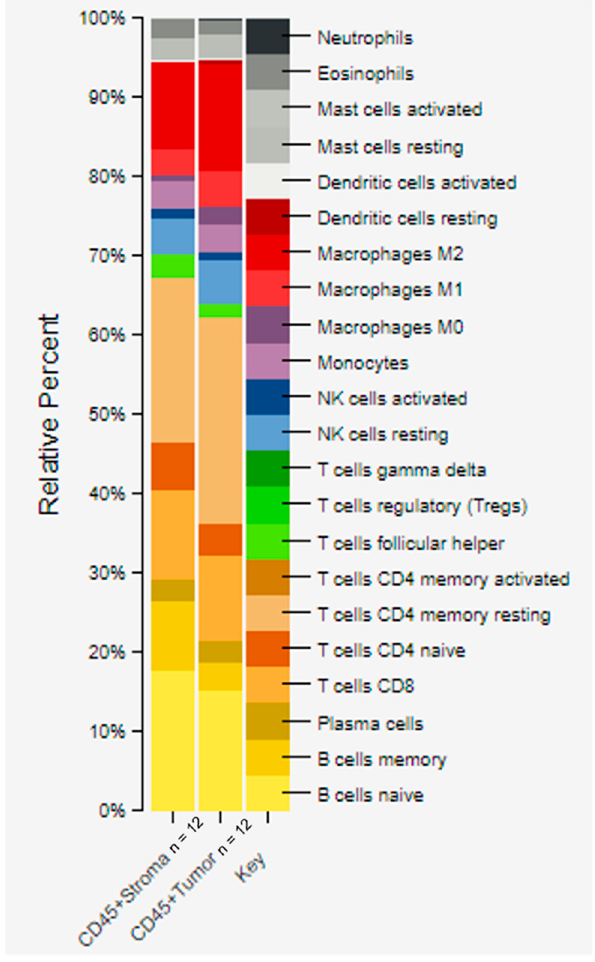
Figure 6. CIBERSORTx analysis of CD45+ stroma and tumor using gene expression data. Quantitative differences were estimated among immune cells from tumor and stroma that contained CD45 positive cells. The stacked bar graphs were generated by providing a normalized gene expression matrix to CIBERSORTx. Higher enrichment in CD45+ TAS compared to CD45+ tumor epithelium was seen in: naïve B cells (18% vs. 15%), memory B cells (9% vs. 3%), and naïve CD4 T cells (6% vs. 4%). In contrast, a higher fraction in CD45+ tumor compared to CD45+ TAS was seen in: memory resting CD4 T cells (26% vs. 21%), M1 macrophages (5% vs. 3%), and M2 macrophages (13% vs. 11%). ROI = region of interest; TAS = tumor-adjacent stroma.